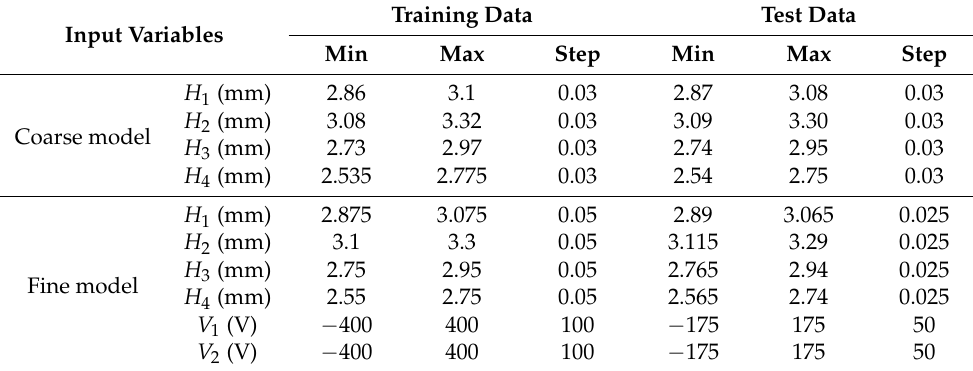
Table 4. Definition of training and test data for multiphysics parametric modeling of the three-pole waveguide